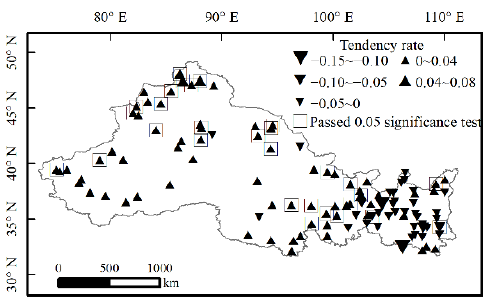
Figure 3. Spatial distribution of interannual trends of humidity index in five provinces of Northwest China from 1960 to 2020.